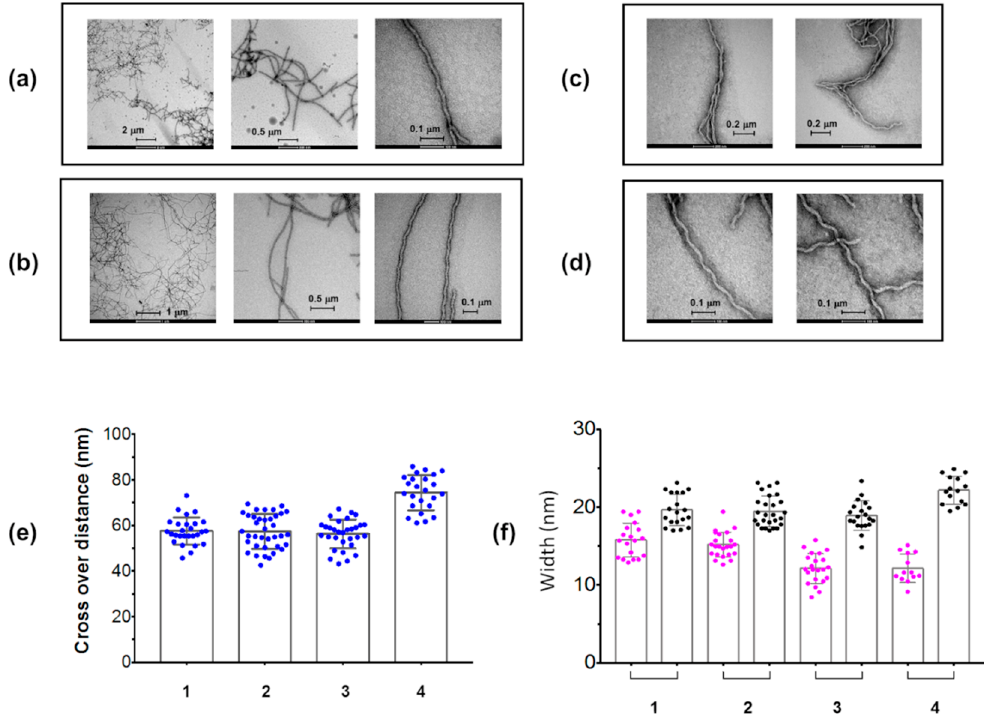
Figure 6. TEM representative images of ( a ) Ub 2 (48)tau4RD(353), ( b ) Ub 2 (63)tau4RD(353), ( c ) tau4RD ∆ C, and ( d ) Ub-tau4RD(353), after 48 h of incubation at 37 ◦ C under static condition. 30 µ L of sample at a concentration of 2.5 µ M were deposited. Distributions of ( e ) cross-over distances and ( f ) widths of the twisted filaments measured from TEM images of Ub 2 (48)tau4RD(353) (1), Ub 2 (63)tau4RD(353) (2) and Ub-tau4RD(353) (3) conjugates and tau4RD ∆ C (4). In ( e ) and ( f ), dots indicate single measurements and bars the positions of means ± SD. In ( f ), dots in magenta refer to the measures of narrow widths and in black to large